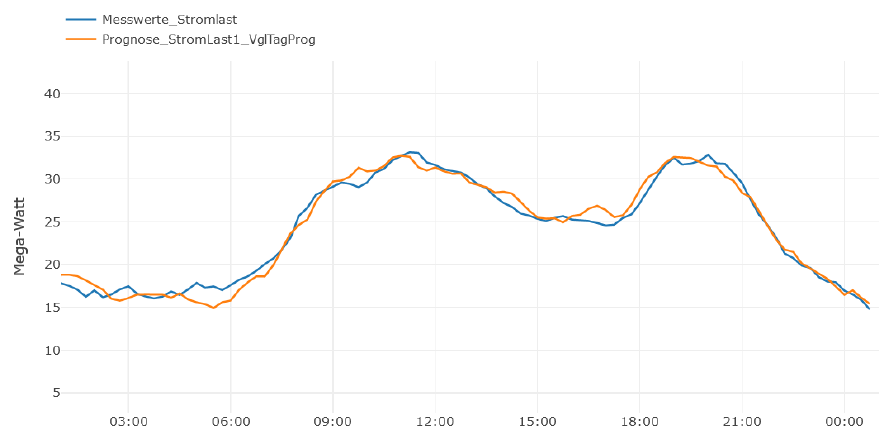
Figure 5. UC2 Energy prediction and actual